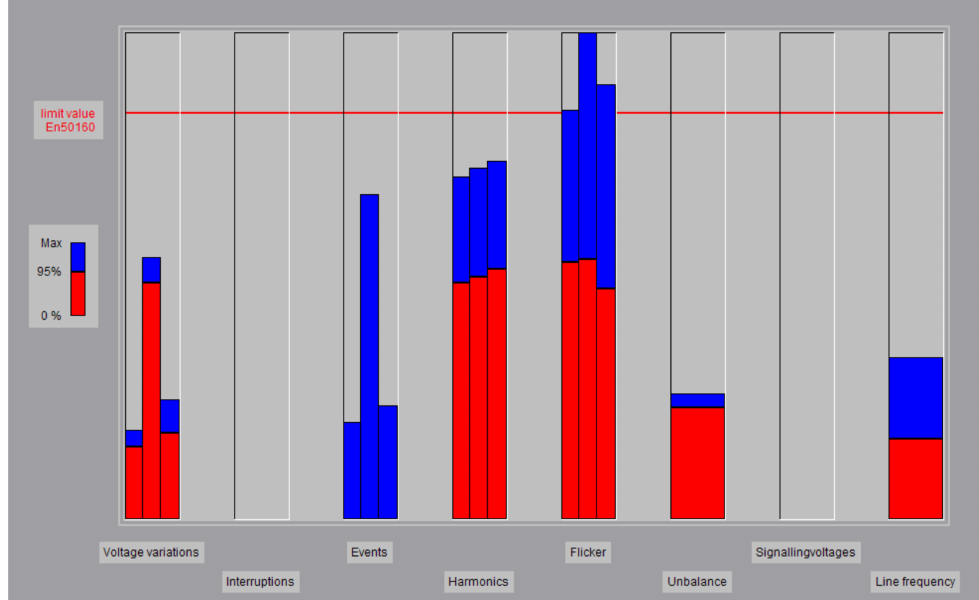
Figure 10. Graphical presentation of power quality indicators measured in the supply line traction substation—Point B.